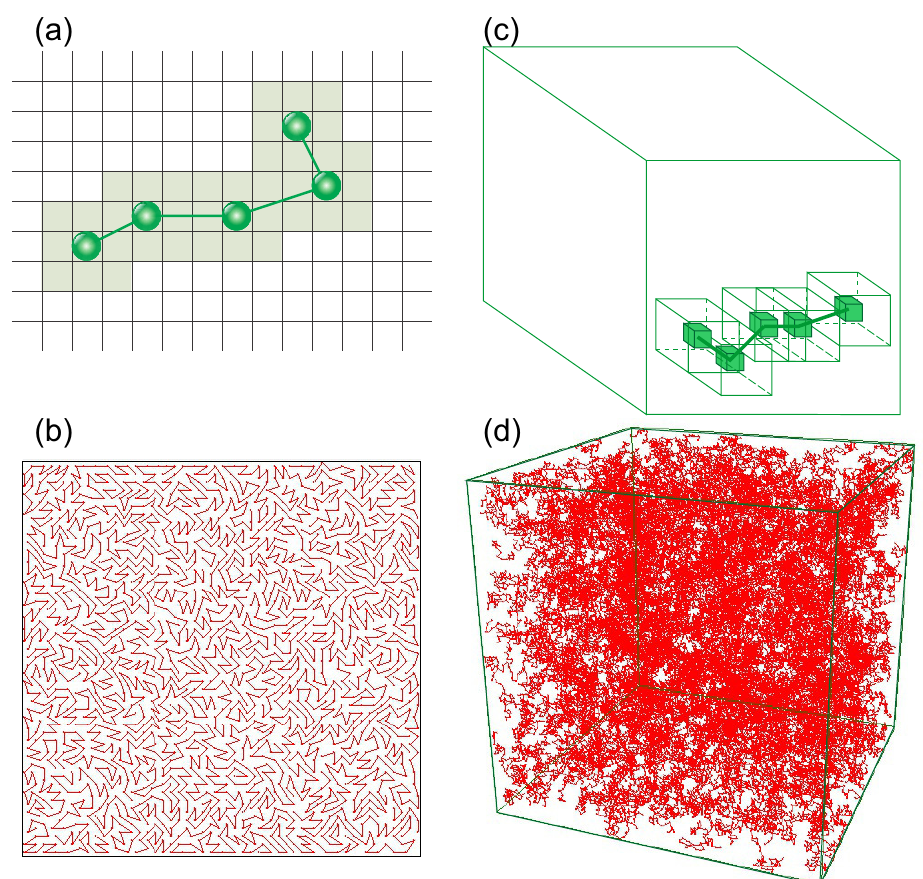
Figure 2. Lattice bond fluctuation model in 2D ( a ) and 3D ( c ). Exemplary configurations in 2D ( b ) and 3D standard system ( d ). Based on